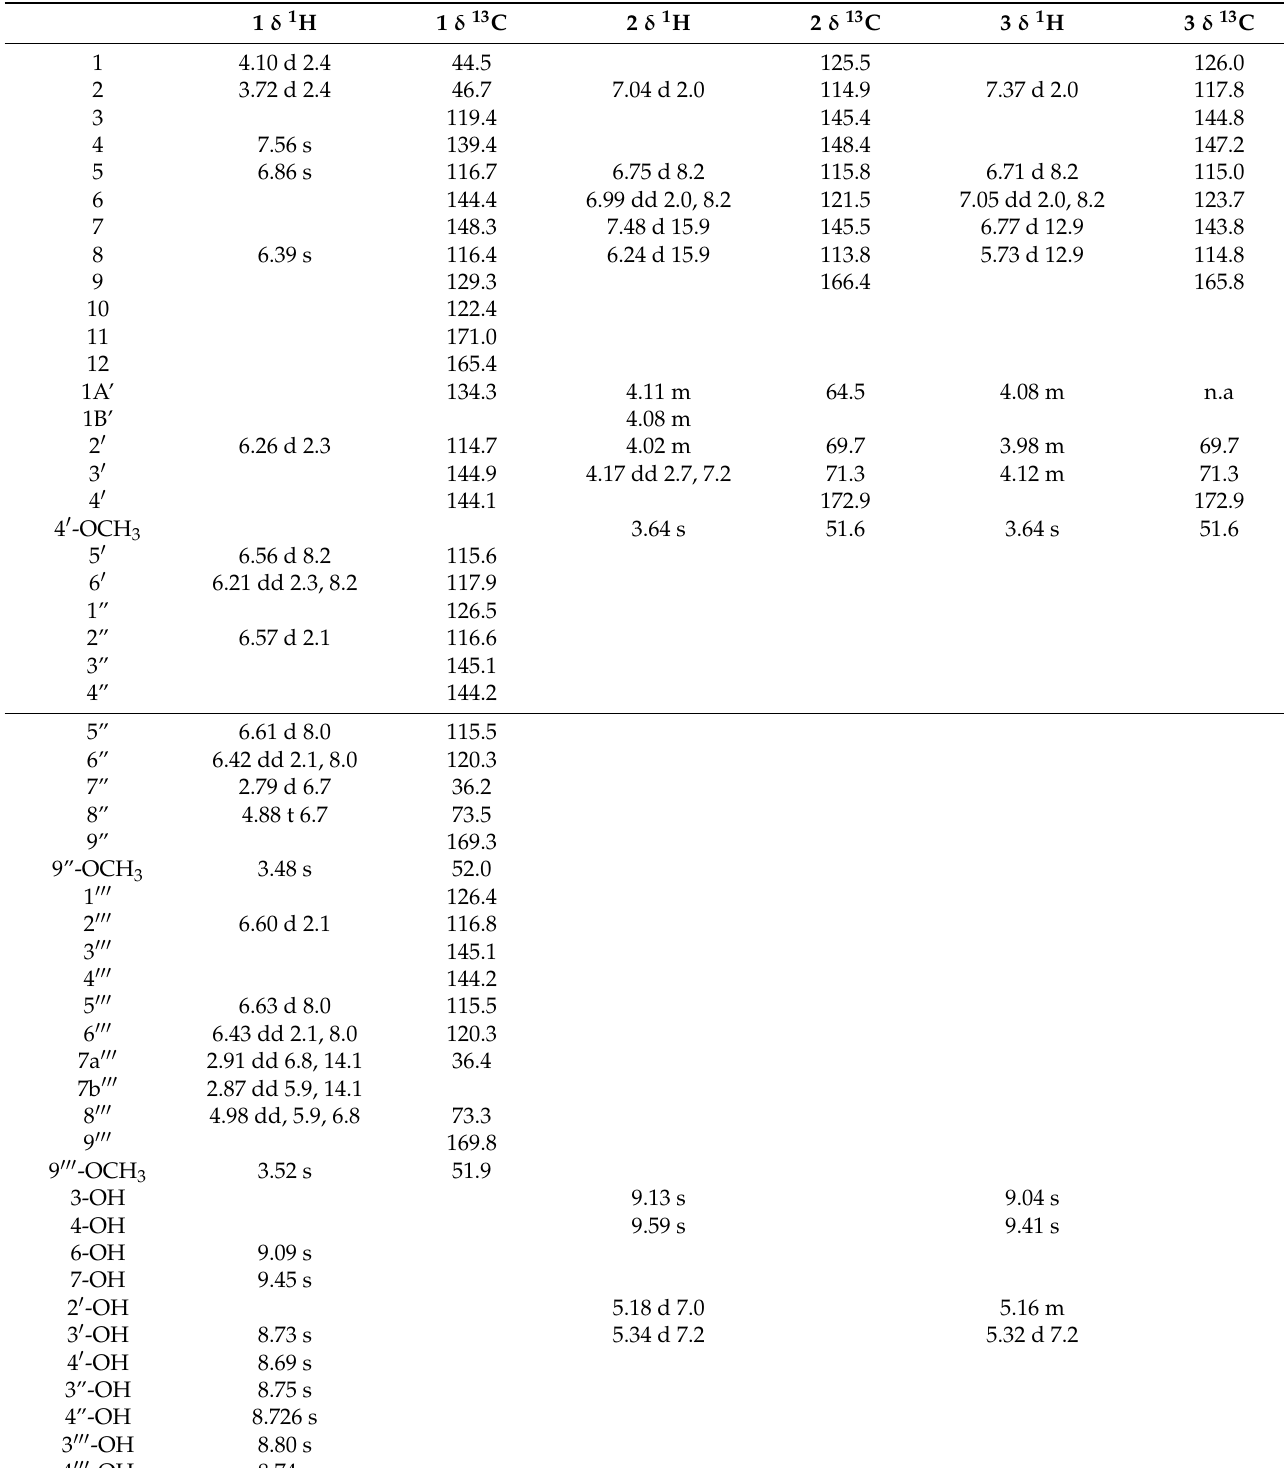
Table 1. 1 H and 13 C NMR chemical shift values (ppm) and coupling constants (Hz) of